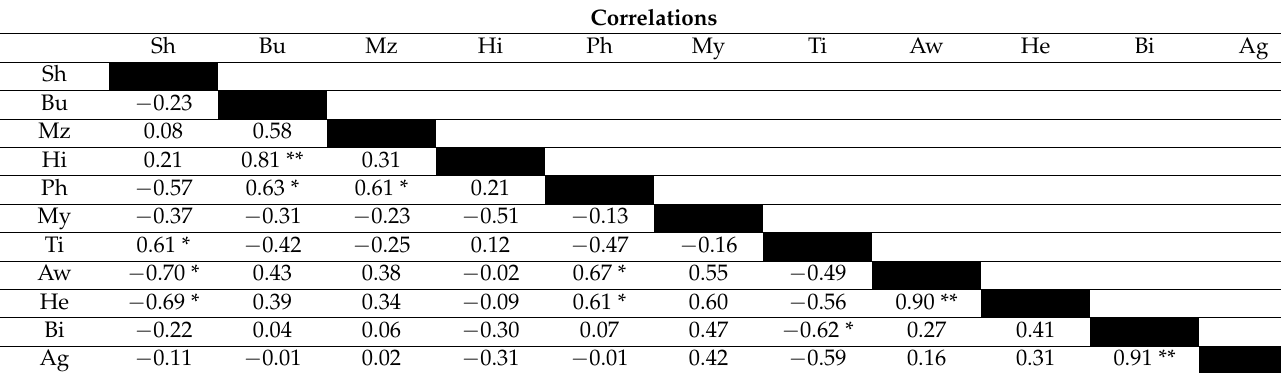
Table 1. Pearson correlation between plant species richness in the surveyed sites within the Aswan reservoir area. Sh: El